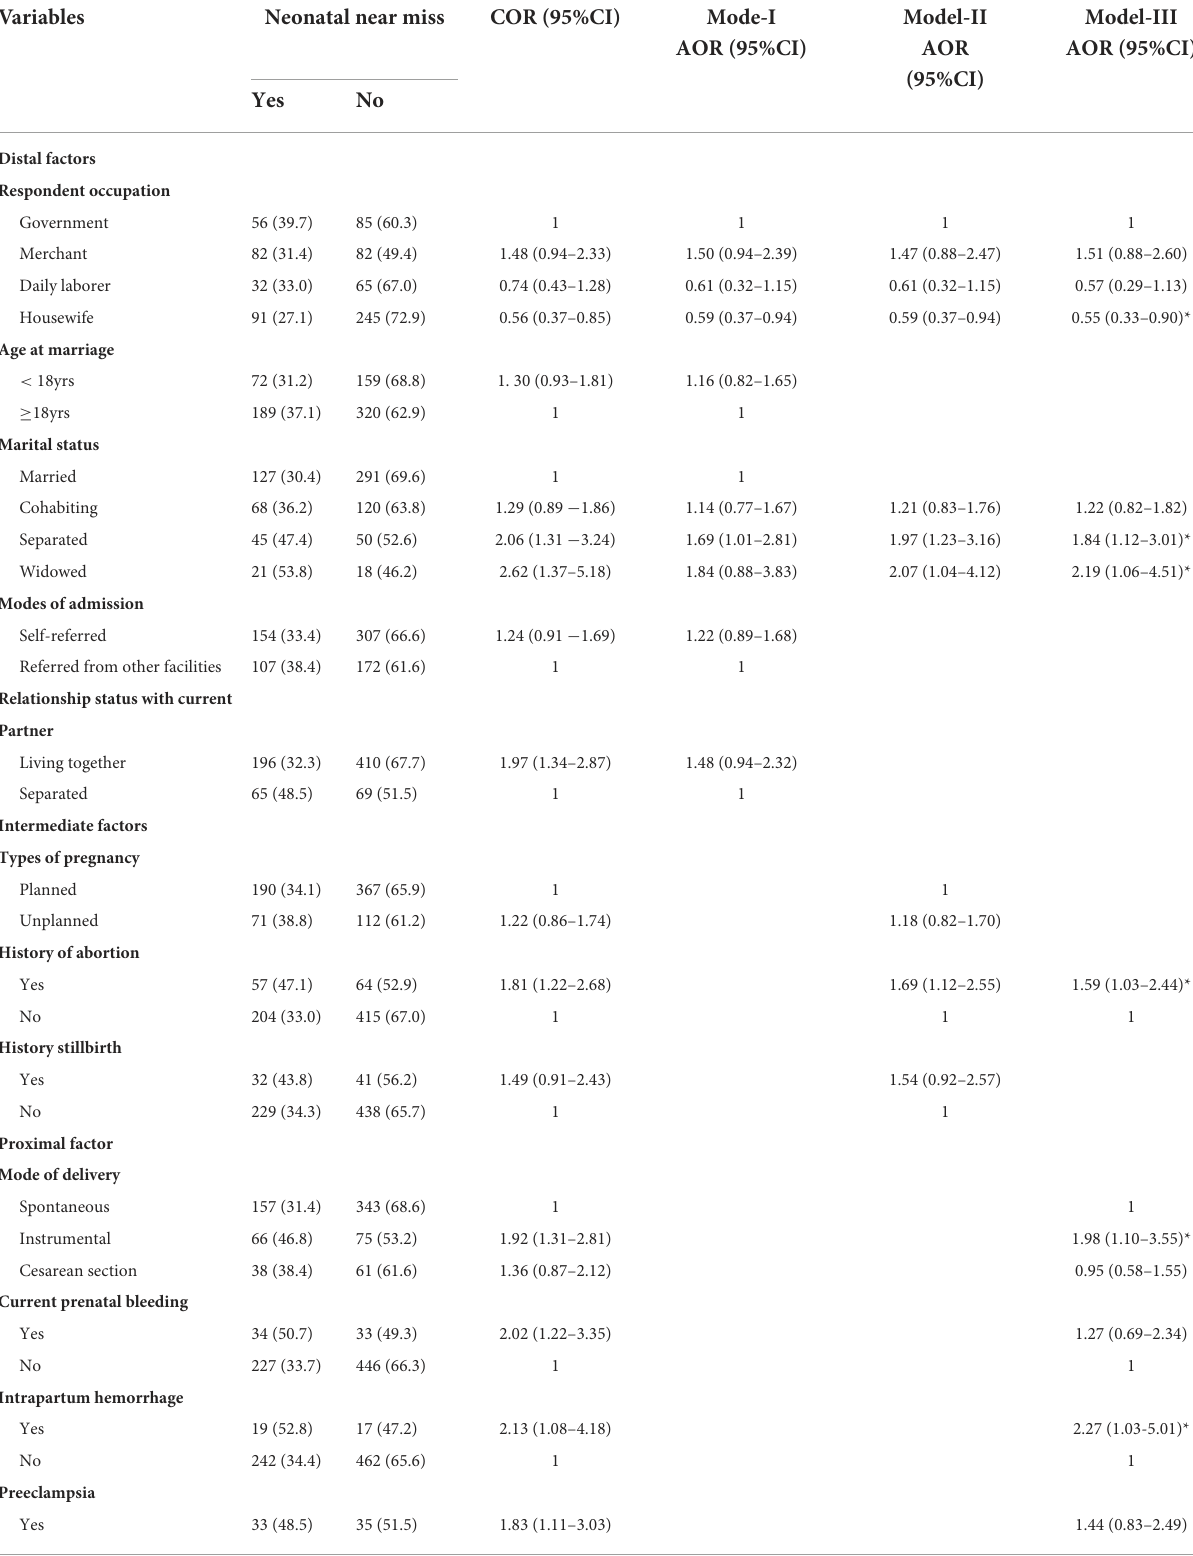
TABLE 6 Determinant of NNM among neonates delivered in North Shewa zone public health facility, Oromia region, Ethiopia,